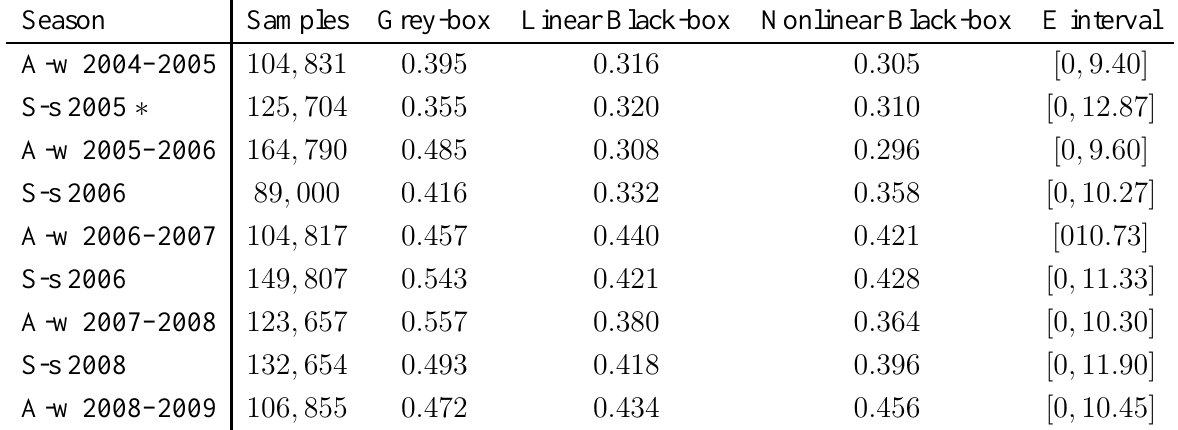
Table 4. Virtual sensor error comparison, in g m − 2 min − 1 .